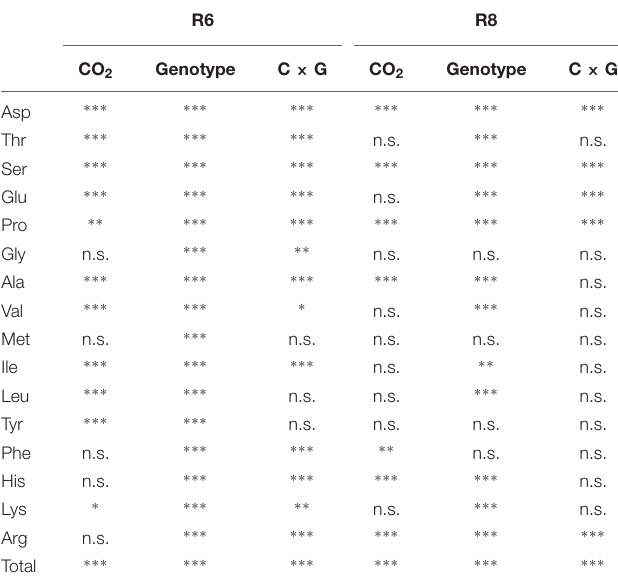
Significant differences between CO 2 treatments for each cultivar are noted with an asterisk at P < 0.05. TABLE 1 | Significance levels of main effects and interactions of CO 2 and cultivars on soybean grain free amino acid concentrations at R6 and R8. R6 R8 1.4%, 5.5%, 2.1%, and 9.6% ( P < 0.05). Together, oleic acid and linoleic acid accounted for more than 75% of the total oil Genotype Genotype